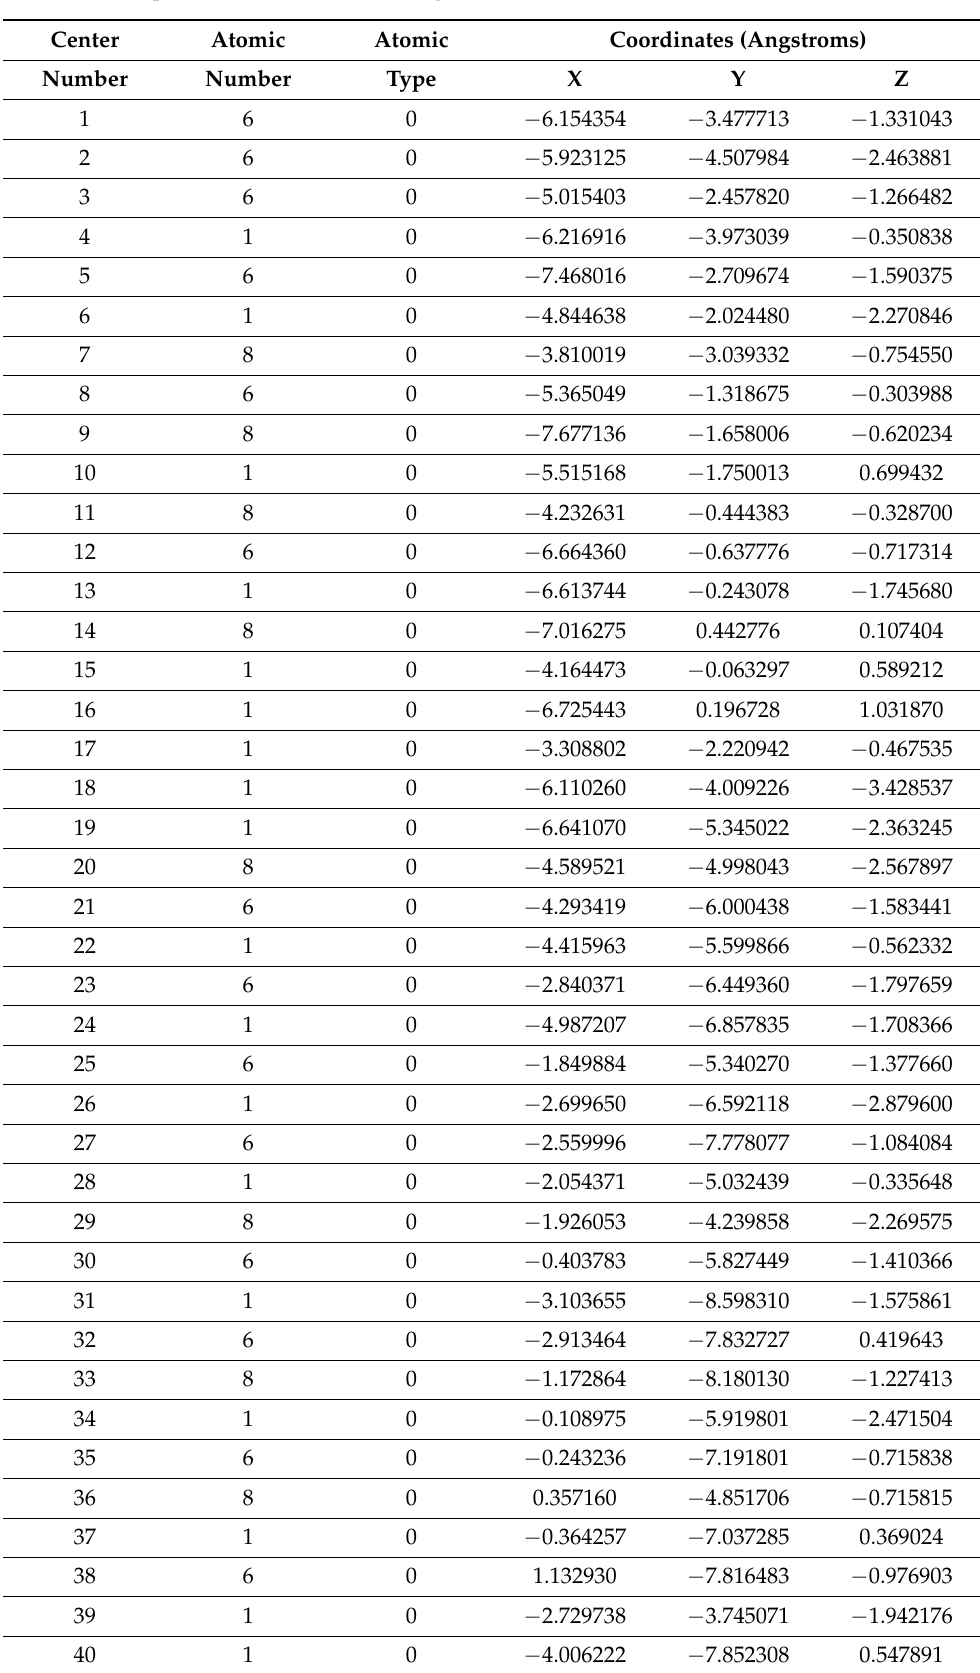
Table A3. Complex III. I 3- in the dextrin